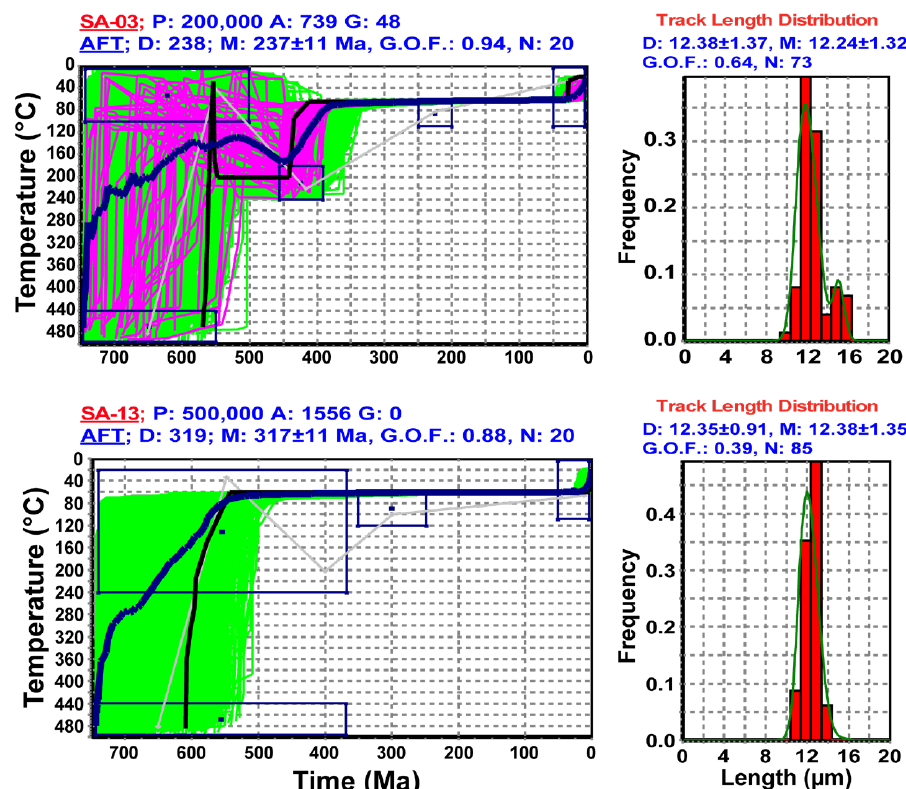
Figure 4. Thermal history models for all samples were obtained using HeFTy [56]. Resulting t–T curves show four different reliability levels—green paths: acceptable fit (all t–T paths with a merit function value of at least 0.05), purple paths: good fit (all t–T paths with a merit function value of at least 0.5), black line: best fit, and blue line: the weighted mean path [53,56], the dashed grey lines represent the time–temperature grid. Five search boxes were chosen to guide the randomness. Detailed information about the constraints is provided in Table S1. P: number of inverse models’ iterations, A: number of acceptable fit models, G: number of good fit models, D: determined FT age and CLs (1- σ error), M: modelled FT age and HCTs, G.O.F.: goodness of fit, N: number of